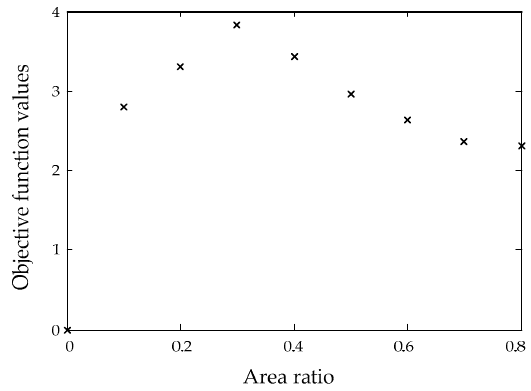
Figure 10. The objective function values under different area ratio.